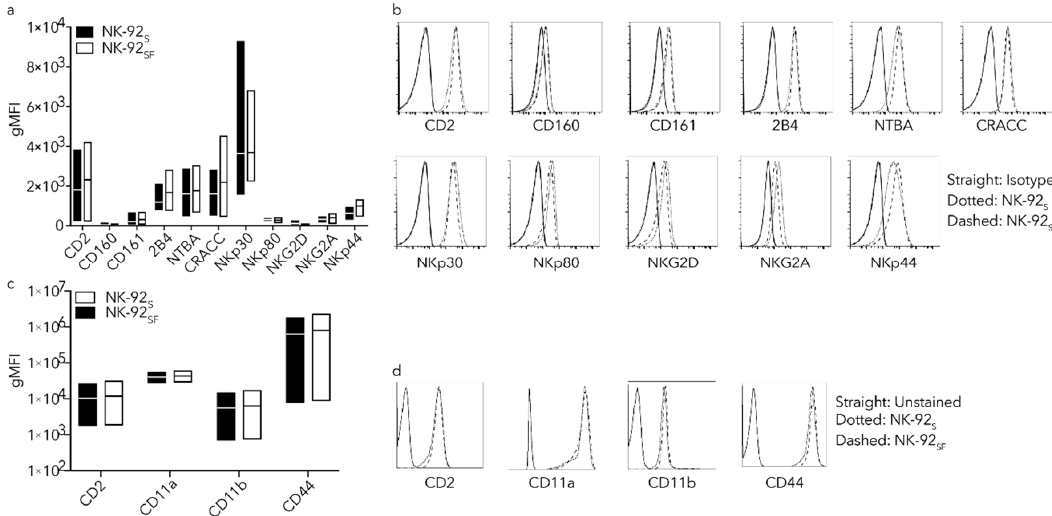
Figure 3. Receptor expression is not altered on NK-92 SF cells. NK-92 cells were analyzed with a full panel of NK-cell markers. Only markers with detected expression, i.e., higher than unstained samples, are shown in the figure. Geometric mean fluorescent intensity (gMFI) of NK cell markers activation markers ( a ) or adhesion markers ( c ) on NK-92 S and NK-92 SF cells. ( b ) Representative histograms showing indicated receptor expression. Straight line shows isotype control, dotted line shows receptor expression on NK-92 S , and dashed line shows receptor expression on NK-92 SF . ( d ) Representative histograms for adhesion receptors on NK-92 cells. Straight line shows unstained control, dotted line shows receptor expression on NK-92 S cells, and dashed line shows receptor expression on NK-92 SF cells. Floating bars show mean and min/max value of three independent assays performed as a single or duplicate experiment.